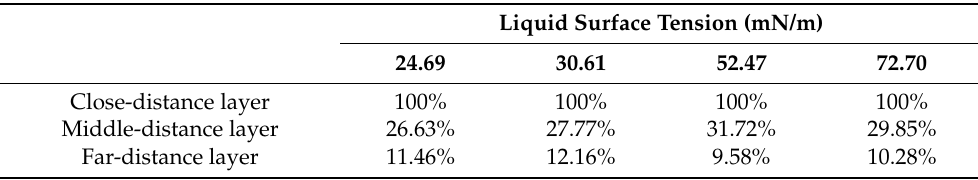
Table 13. Calculation results of the droplet penetration ratio in the